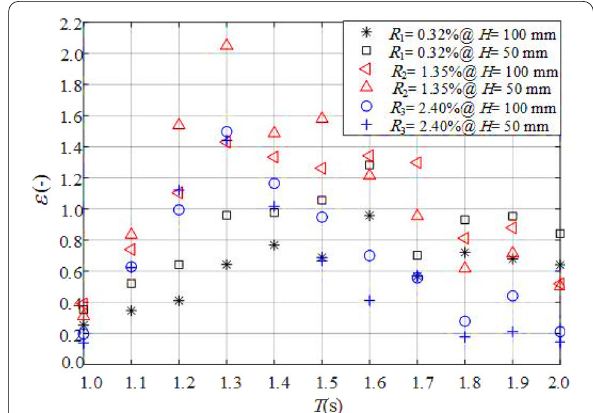
Figure 11 The impact of three orifice opening ratios (PTO damping) and two wave heights on the total capture width ratio ( ε ) under